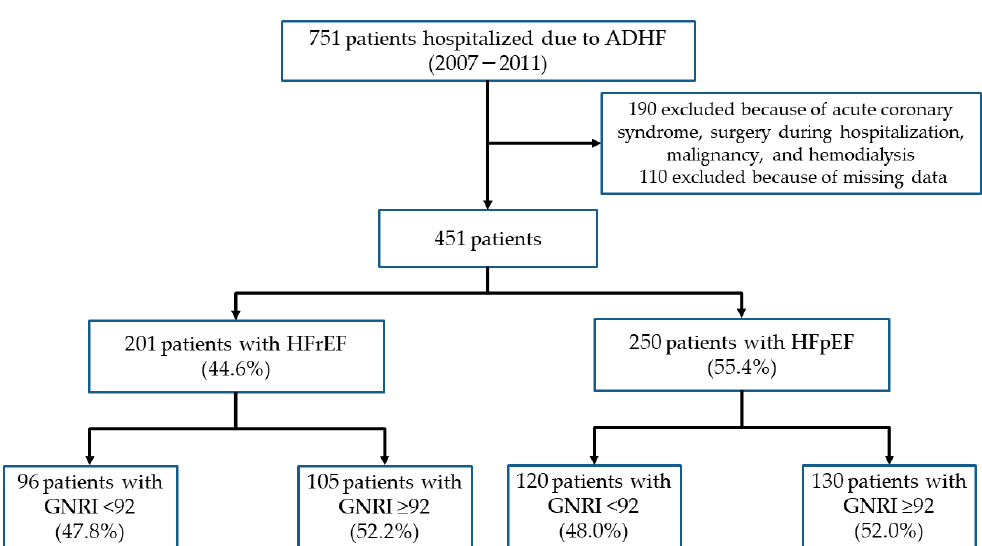
Figure 1. Flow diagram of this study. A total of 751 patients were admitted to the cardiac intensive